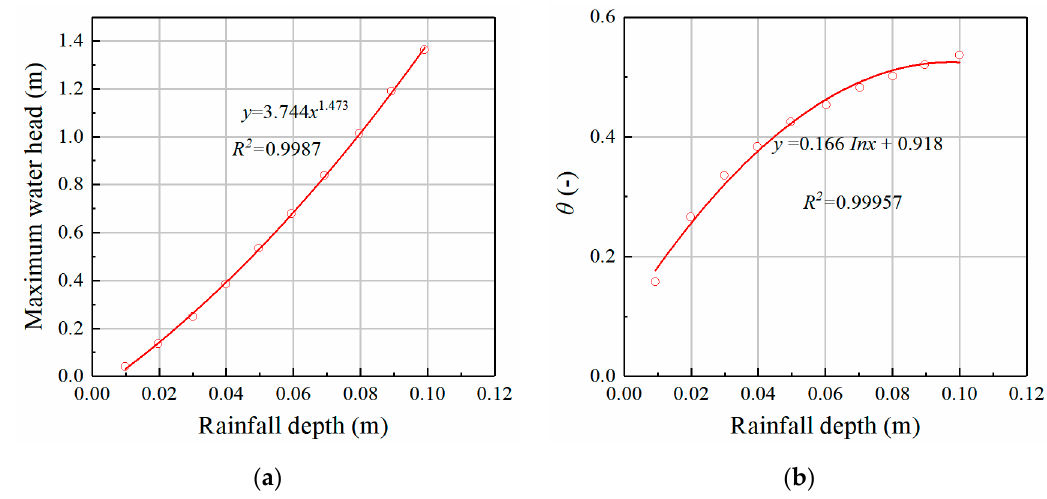
Figure 8. The buffer tank performs better in case of a greater rainfall depth. ( a ) Culminations of water head in the buffer tank increase with the rainfall depth; ( b ) the peak flow is attenuated at a greater level at heavier rainfall.